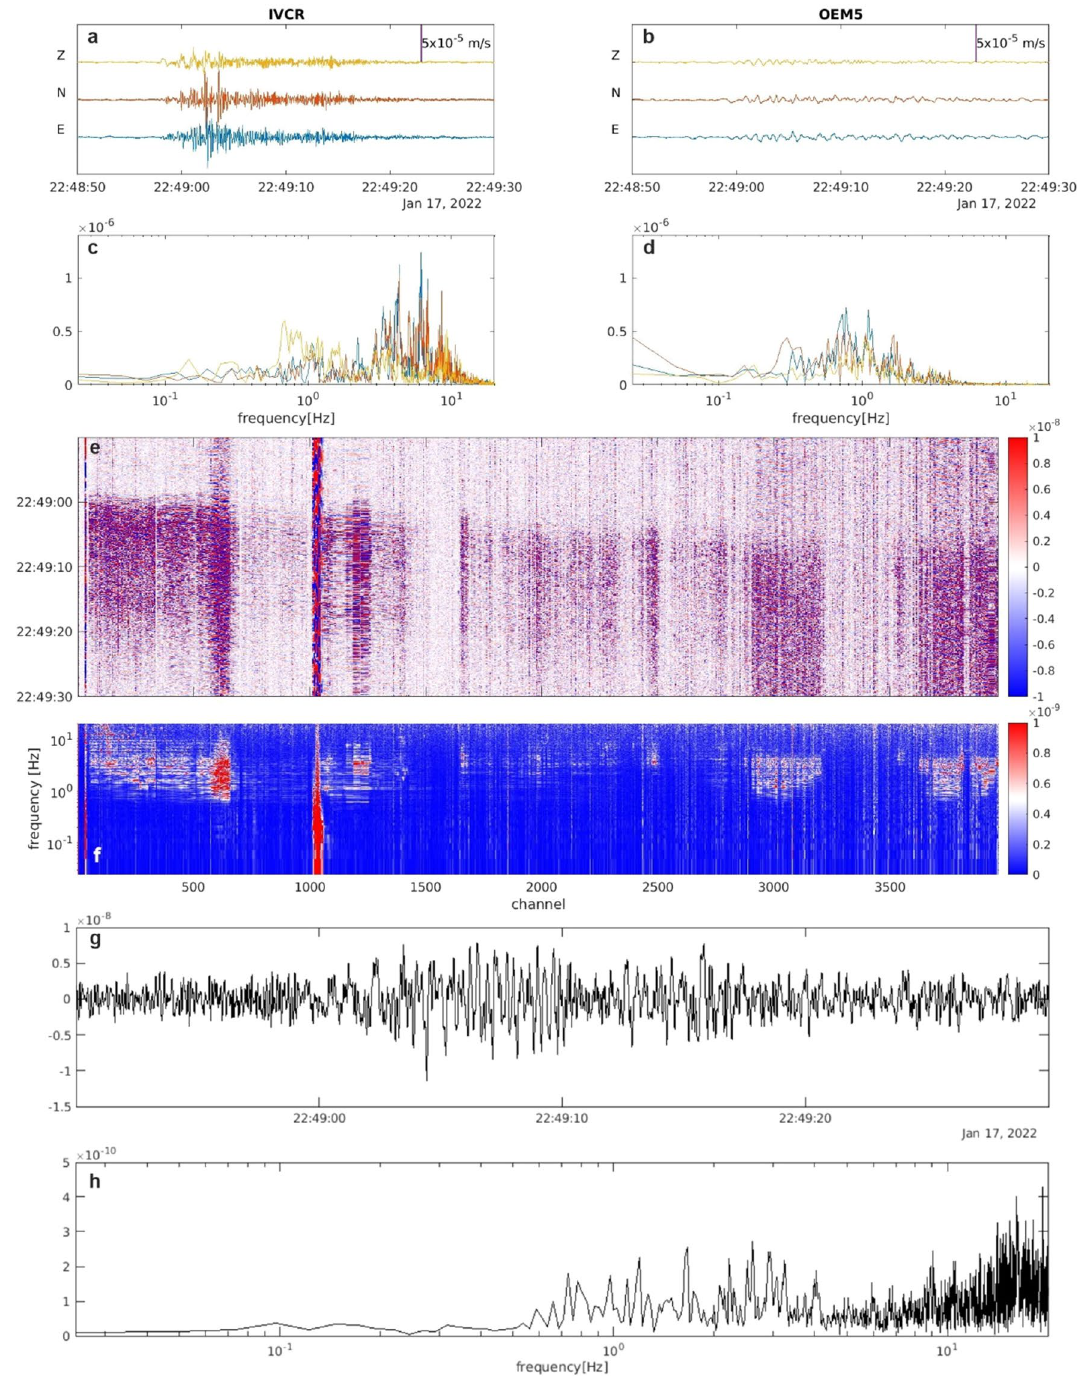
Figure 3. Example of LP event: ( a , b ) 3C seismic signals recorded at IVCR (in the summit area) and at OEM5 (nearest to the fiber) and their spectra ( c , d ). ( e ) DAS strainrate signal filtered below 10 Hz. ( f ) Full spectra of the DAS strainrate record. Traces of the DAS strainrate ( g ) and its spectrum ( h ) at the channel near to the OEM5